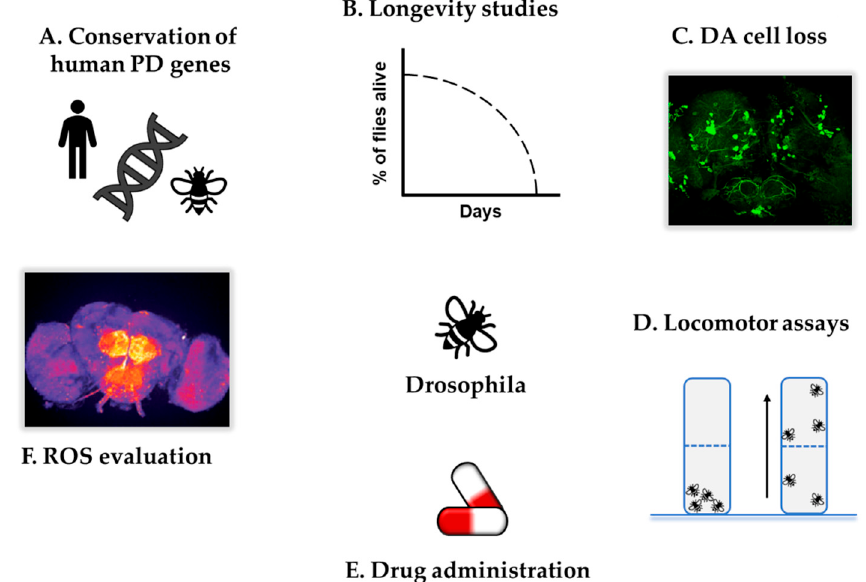
Figure 2. Advantages of Drosophila melanogaster as a model organism to investigate PD. D.